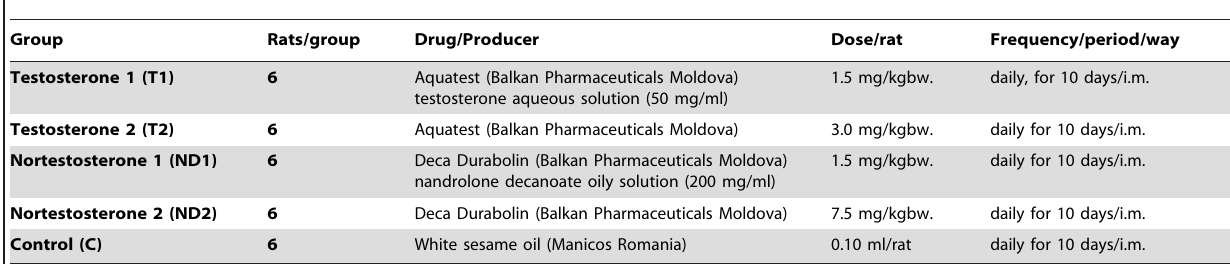
Table 1. Protocol of substances